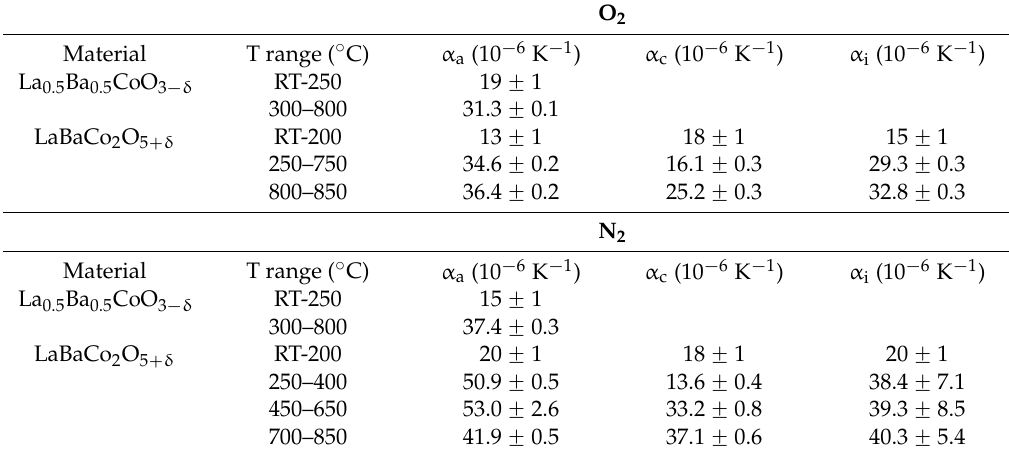
Table 2. Thermal expansion coefficients of the unit cell parameters ( α a and α c ) and the isotropic linear